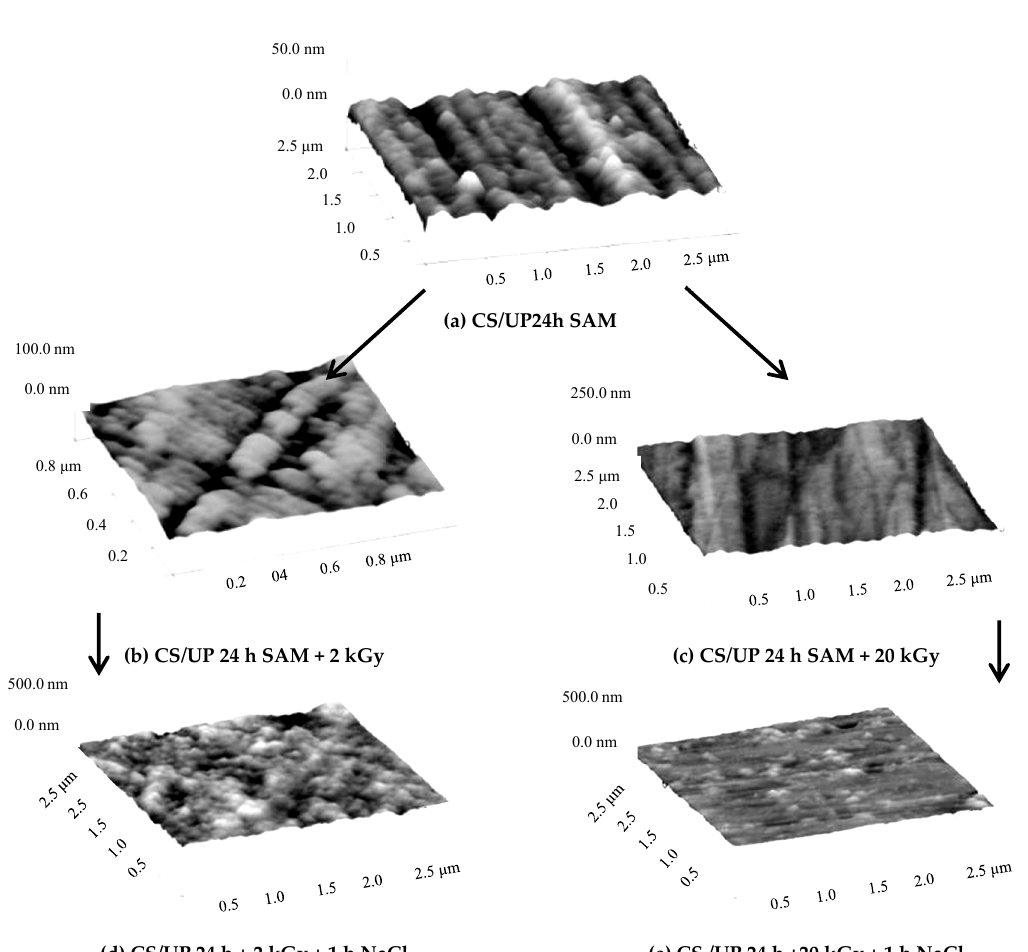
Figure 2. Influence of irradiation on the structure of the carbon steel (CS) surface covered by undecenyl phosphonic acid (UP) SAM layer surface on the anticorrosion activity, visualized by atomic force microscopy (NanoScope III, contact mode, ex-situ experiments), ( a ) carbon steel covered by UP, ( b ) CS/UP irradiated by 2 kGy; ( c ) CS/UP irradiated by 20 kGy; ( d ) sample “b” immersed into NaCl solution; ( e ) sample “c” immersed into NaCl solution; (UP 24 h: undecenyl phosphonic acid SAM layer developed in 24 h, 2 kGy, and 20 kGy: irradiation via 60 Co gamma source by 2 kGy and 20 kGy) [56] 2018, International Journal of Corrosion and Scale Inhibition (copyright given by Prof. Andreev, the editor of the journal).